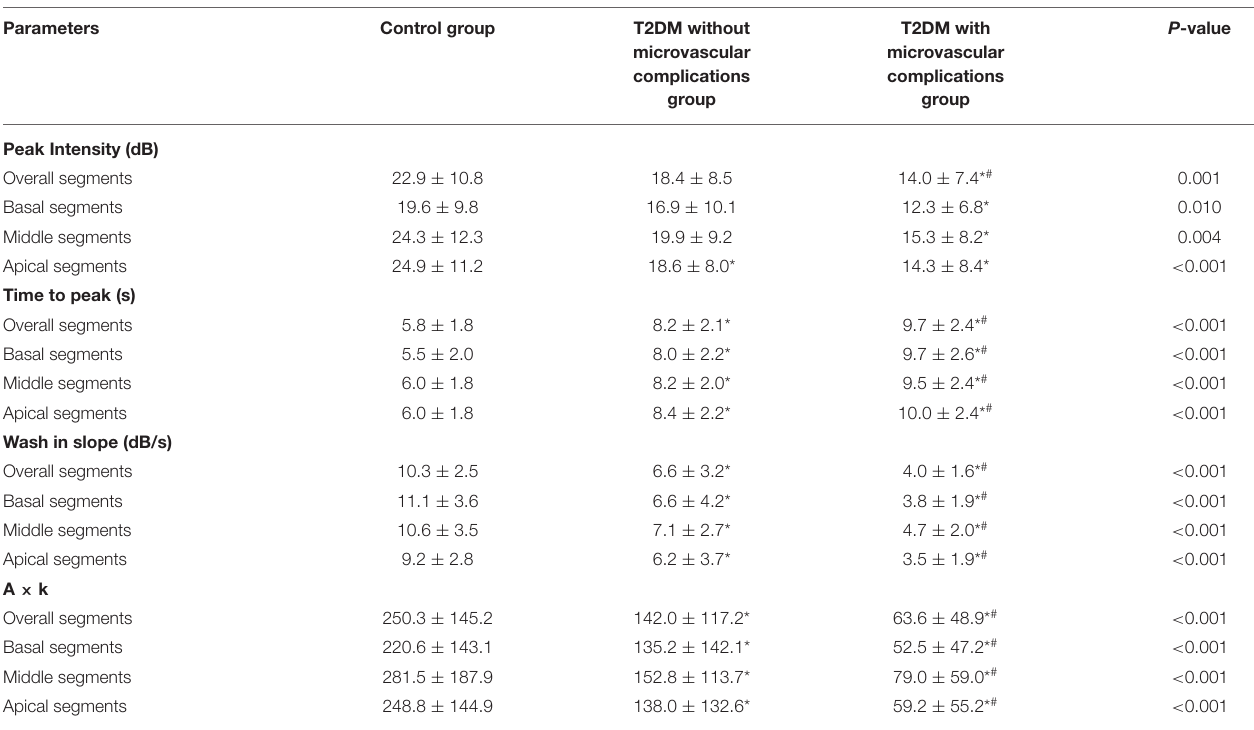
TABLE 3 | Comparison of MCE parameters in three